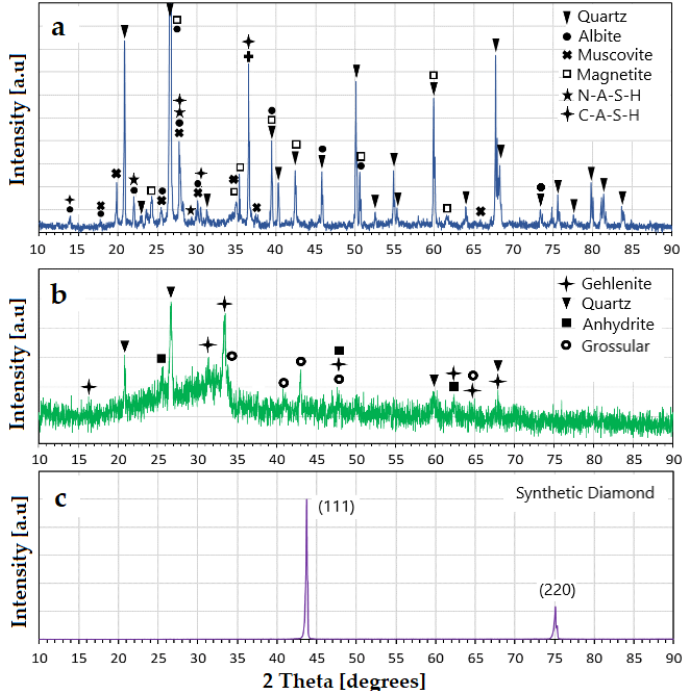
Figure 4. XRD patterns. ( a ) Raw MTs. ( b ) Raw FAc. ( c ) Synthetic diamond used in QXRD analysis.